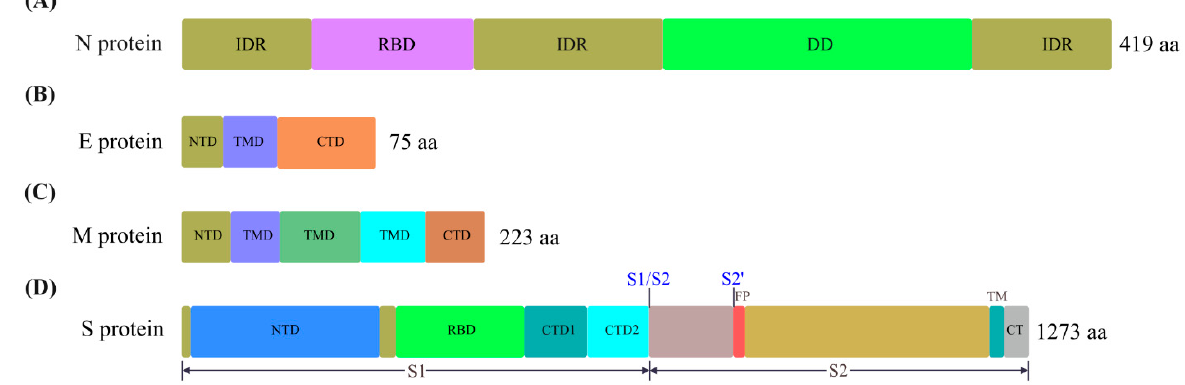
Figure 3. Domain structures of SARS-CoV-2 N, E, M, and S structural proteins. ( A ) N protein. IDR, intrinsically disordered region. RBD, RNA binding domain. DD, dimerization domain. ( B ) E protein. NTD, N-terminal domain (NTD). TMD, transmembrane domain. CTD, C-terminal domain. ( C ) M protein. ( D ) S protein. RBD, receptor-binding domain. FP, fusion peptide. TM, transmembrane anchor. CT, cytoplasmic tail. The aa denotes the amino acids. The size of the diagram of S protein is not proportional to those of N, E, and M proteins.